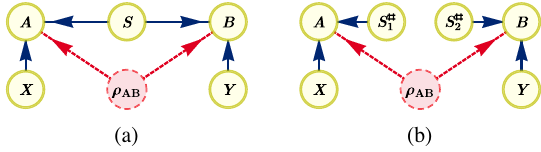
FIG. 6. (a) A Bell-like causal structure with a setting common to both parties and (b) its maximal interruption, which is a Bell causal structure assigning distinct outcome variables wholly distinct input variables. Quantum correlations in the common- setting scenario (a) can be explored by applying the standard NPA semidefinite programming hierarchy [29,30] to the scenario in (b) and then translating back to (a) according to the post- selection relation P 6 ð A ¼ a; B ¼ b j X ¼ x; Y ¼ y; S ¼ s Þ ð a Þ